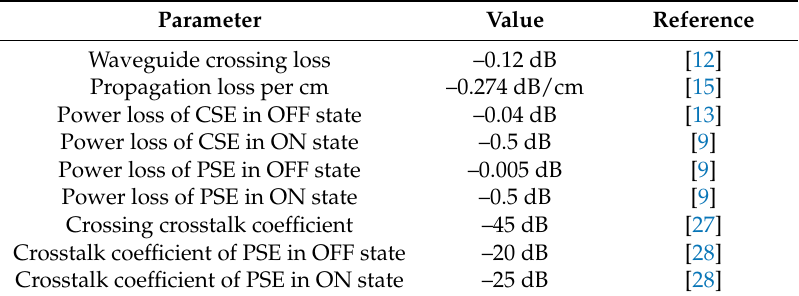
Table 3. Loss and crosstalk coefficient